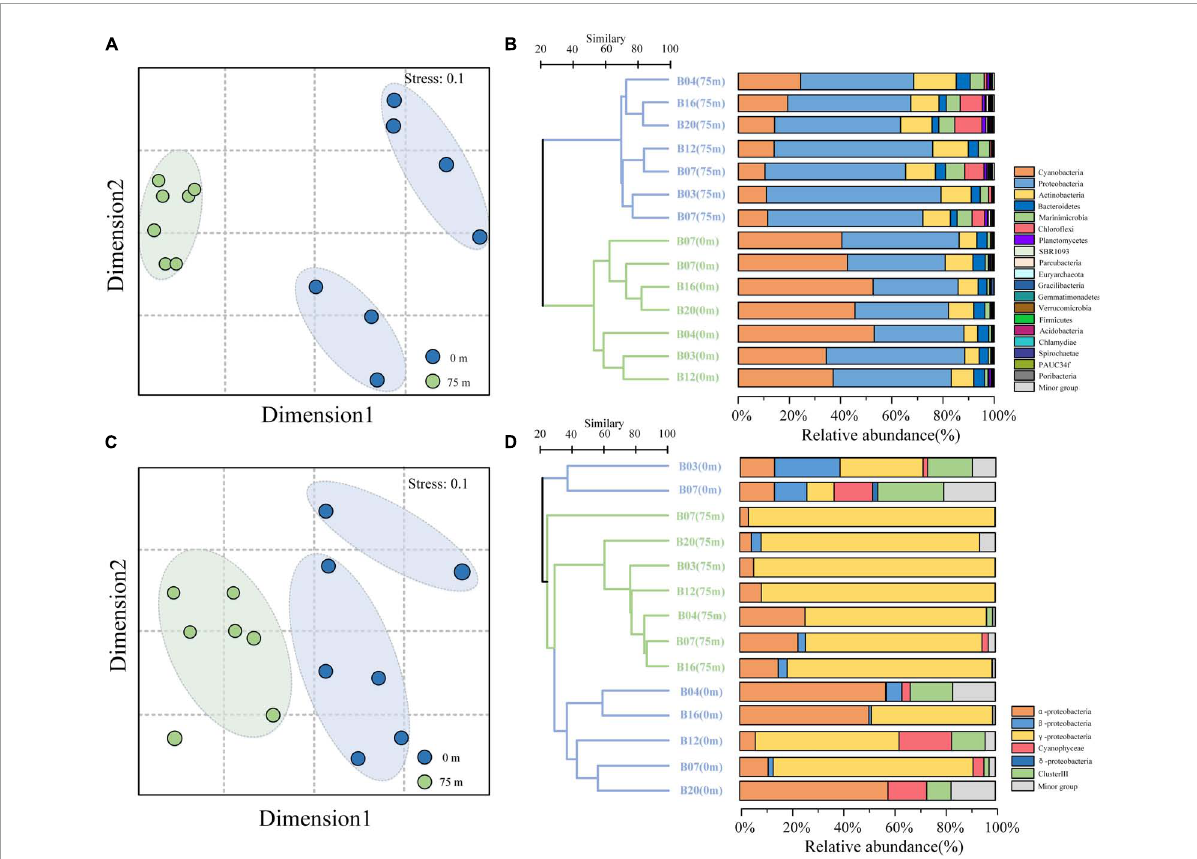
FIGURE3 Non-metric multidimensional scaling (NMDS) analysis and cluster analysis of the bacterial (A,B) and diazotroph community composition (C,D) in the BoB. Samples from different depths were indicated by color.